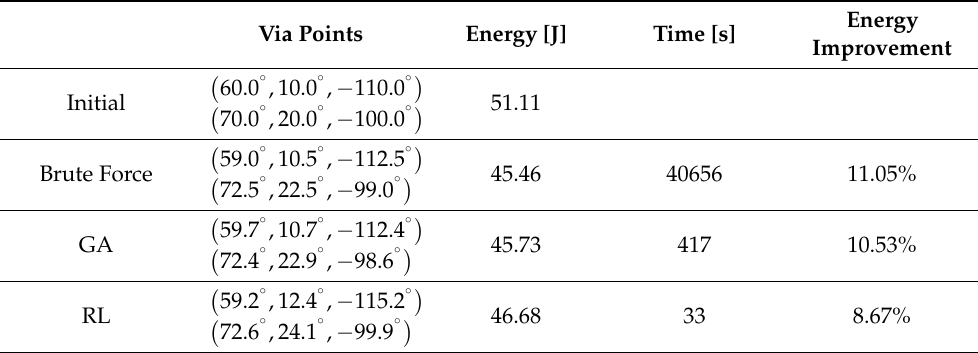
Table 3. Simulation results of the energy optimization